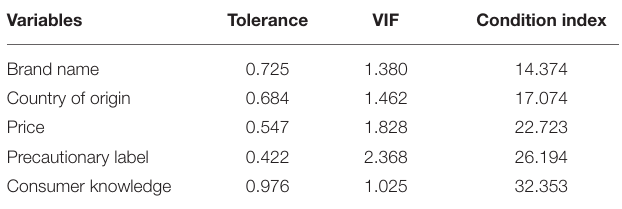
TABLE 9 | Respondents’ profile.